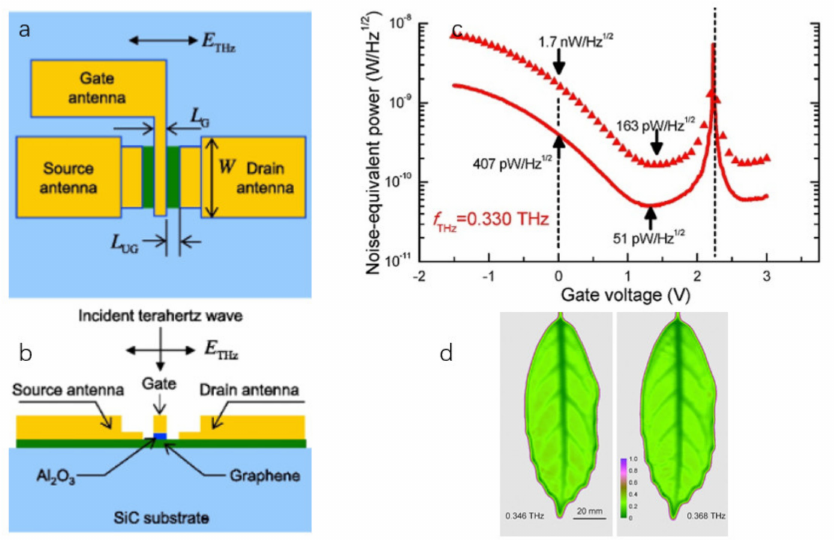
Figure 12. ( a , b ) The top view and front view illustration of the fabricated detector, respectively. ( c ) The red curve calculated from the responsivity at 0.330 THz and the thermal noise of the detector, and the triangle line is calculated based on the responsivity and the noise spectral density dominated by the voltage pre-amplifier. ( d ) The photo of using this detector to image fresh leaves. Reprinted with permission from ref. [140]. Copyright 2021 Copyright Clearance